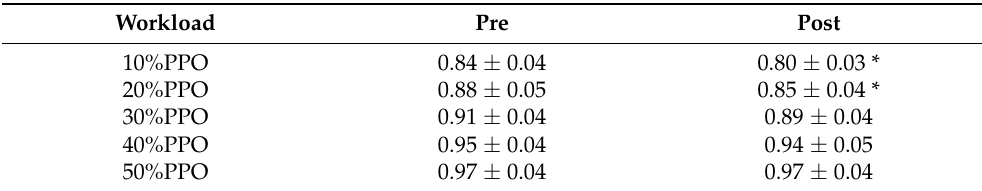
Table 3. Change in respiratory exchange ratio in response to low-volume HIIT (high intensity interval training) in inactive women (mean ± SD). Workload Pre Post 10%PPO 0.84 ± 0.04 0.80 ± 0.03 * 20%PPO 0.88 ± 0.05 0.85 ± 0.04